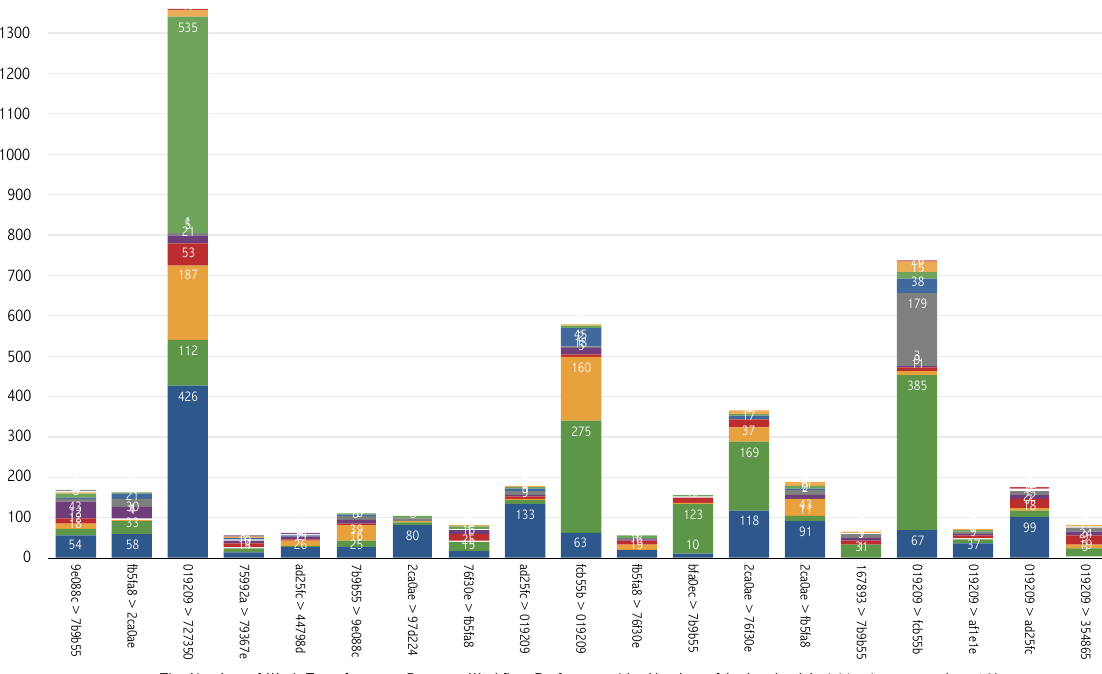
Figure 14. Performers with the number of transferring works to others (10 or more different involved